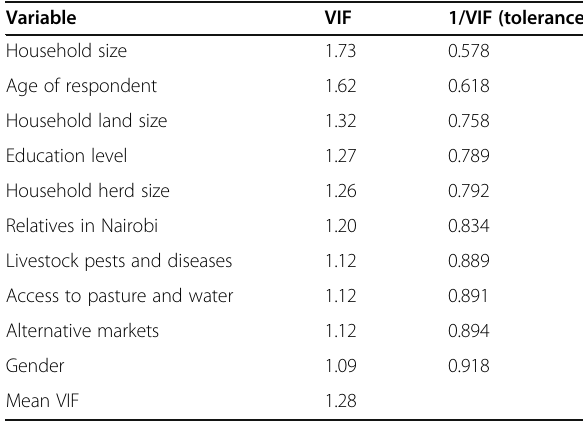
Table 2 Multi-collinearity test for predictor variables in the